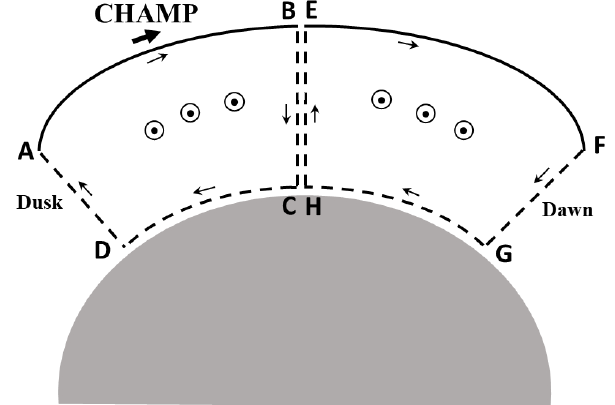
Figure 1. Schematic drawing of the anti-sunward net current (small circles with dots) determination by the ring-integral approach at au- roral latitudes, separately for the dawn and dusk local time sectors. Small arrows indicate the direction of integration. The unsampled but estimated virtual return paths are shown as dashed